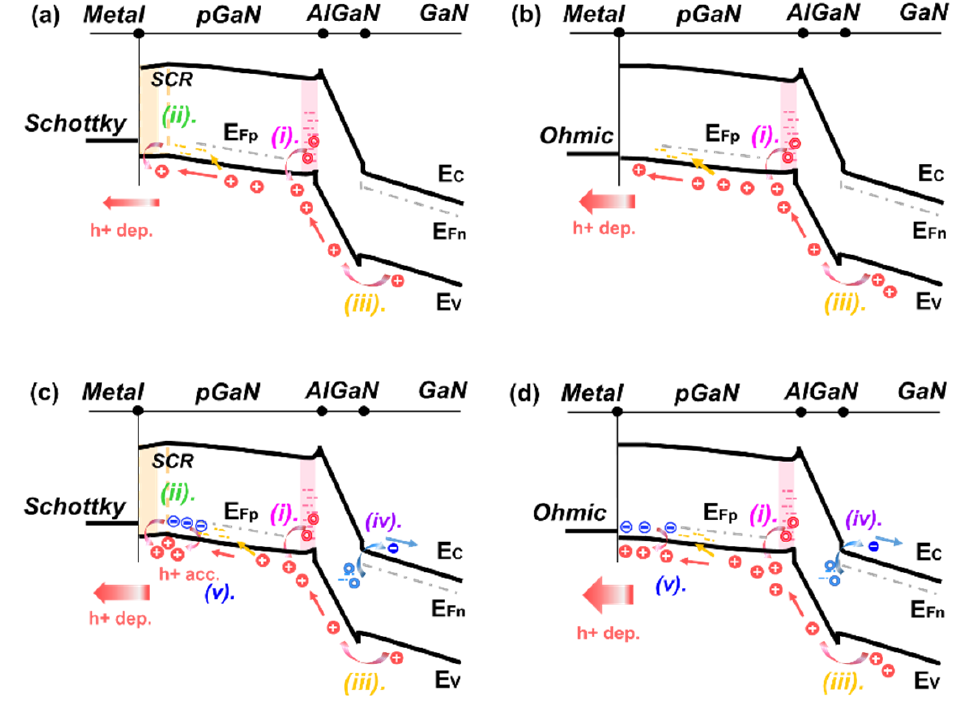
Figure 8. Schematic band diagrams of the gate stack region in the negative gate stress process under room temperature: ( a ) SG HEMT, ( b ) OG HEMT; under elevated temperature: ( c ) SG HEMT, ( d ) OG